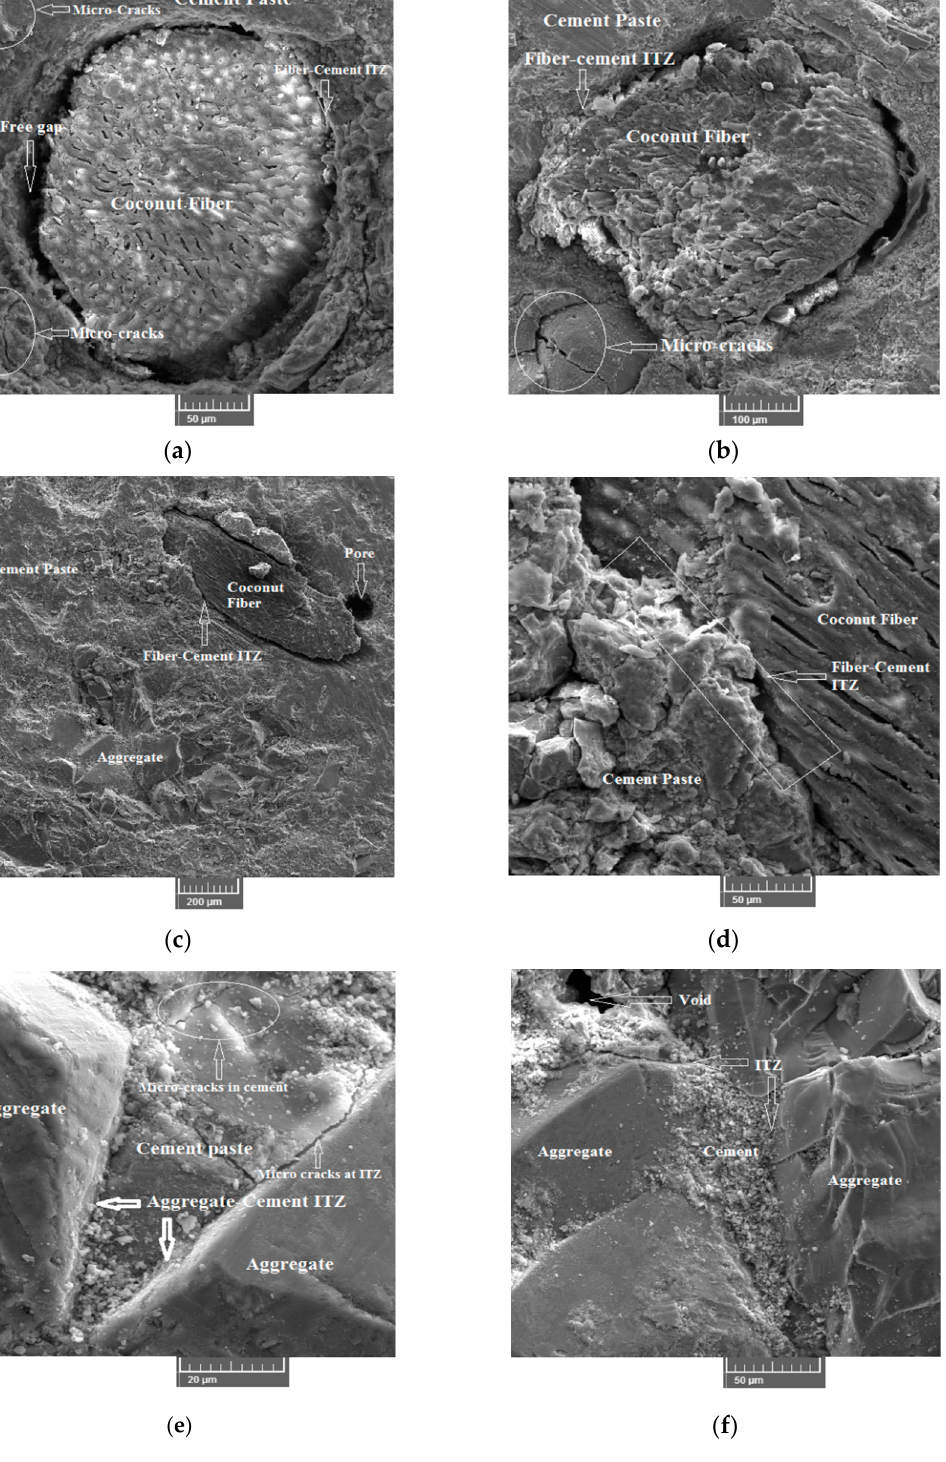
Figure 15. Microstructure of coconut fiber reinforced high strength concrete: ( a ) Gap in fiber-cement paste ITZ and micro-cracks; ( b ) Micro-cracks and fiber-cement paste ITZ; ( c ) Pores in the matrix; ( d ) Fiber-cement paste ITZ; ( e ) Micro-cracks in cement paste and aggregate-cement paste ITZ; ( f ) Aggregate-cement paste ITZ.